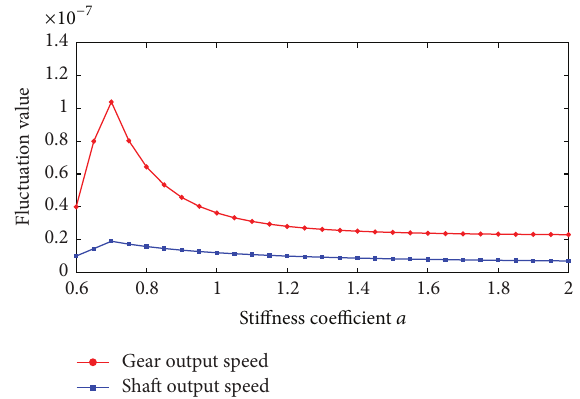
Figure 3: Influence of bearing stiffness on torsional vibration of the